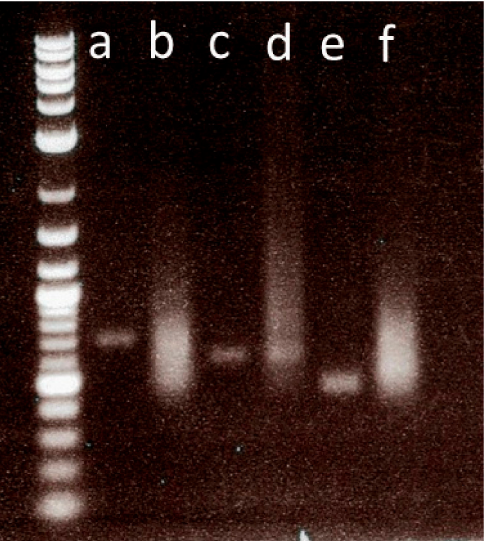
Figure 3. Probe quantity determination. An agarose gel image showing the quantity of anti-sense RNA probes. ( a , c , e ) represent PCR templates for the probes’ synthesis. ( b , f ) High-quantity probes showing thick probe smears ( d ) Low-quantity probe.